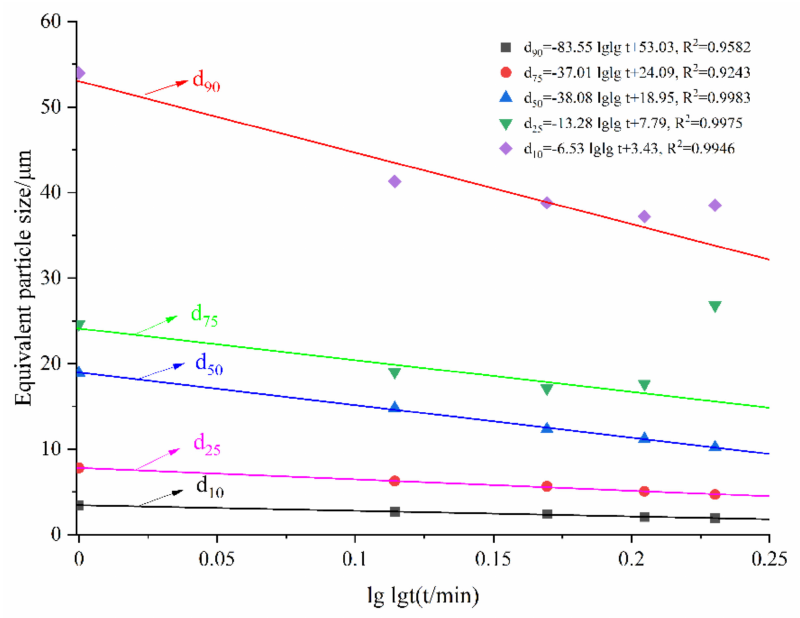
Figure 6. Relationship between the EPS of LVTC powder and the double logarithm of grinding